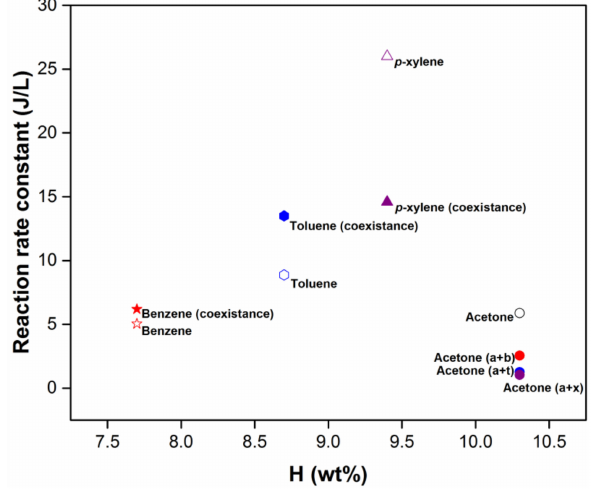
Figure 10. Reaction rate constants of the VOCs with O vs. the hydrogen weight fraction H (wt